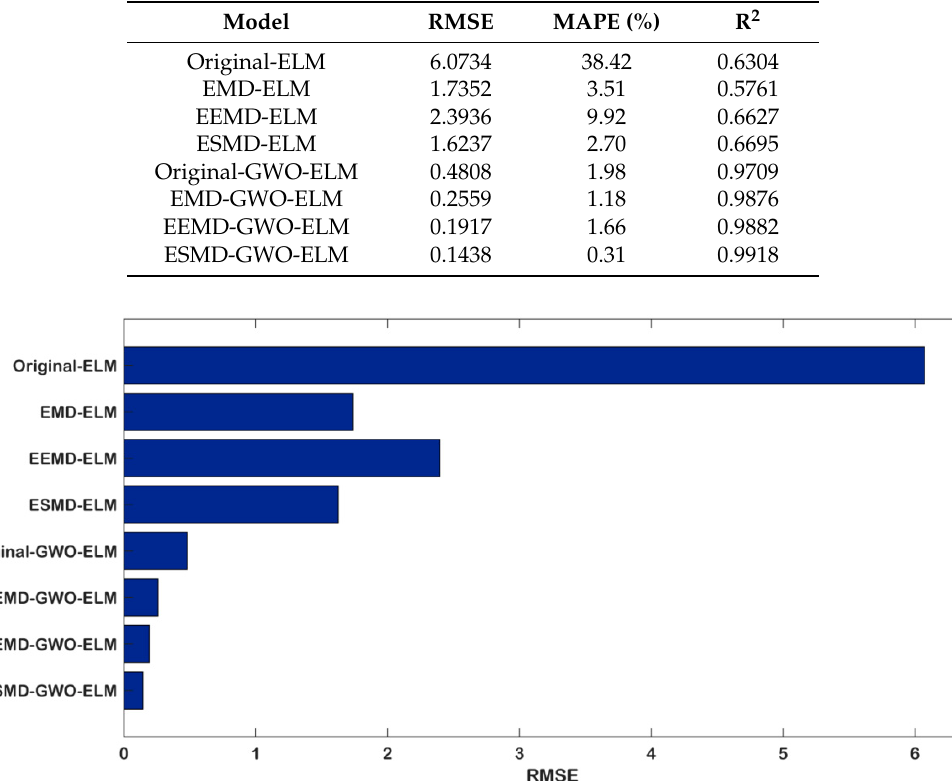
Figure 11. The results of Hubei carbon price forecasting. Table 7. Comparison of the performance of Hubei carbon price forecasting.